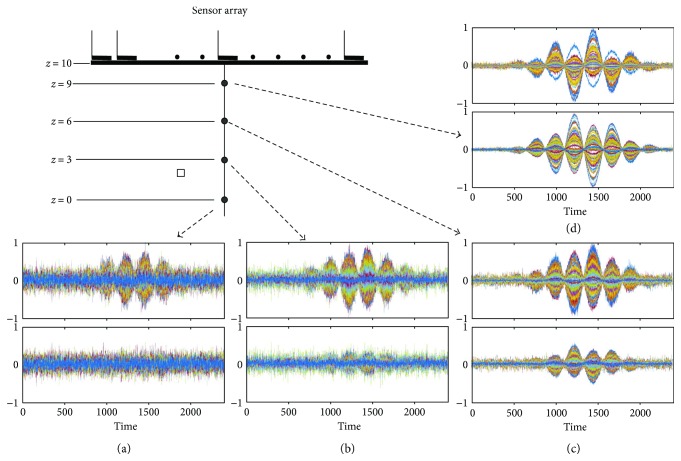
The internal component Pint(bS(t) + ε) and the external component Pext(bS(t) + ε) of the signal vector (plus sensor noise) with four different locations of the origin (0, 0, and zori): (a) zori = 0 cm, (b) zori = 3 cm, (c) zori = 6 cm, and (d) zori = 9 cm. The upper panel indicates the internal components, and the lower indicates the external components PextbS(t). The filled circle shows the location of the origin, and the square indicates the location of the source. In each pair of the sensor time courses, they are normalized to the maximum value from the upper panel, and the ordinate indicates the normalized values.